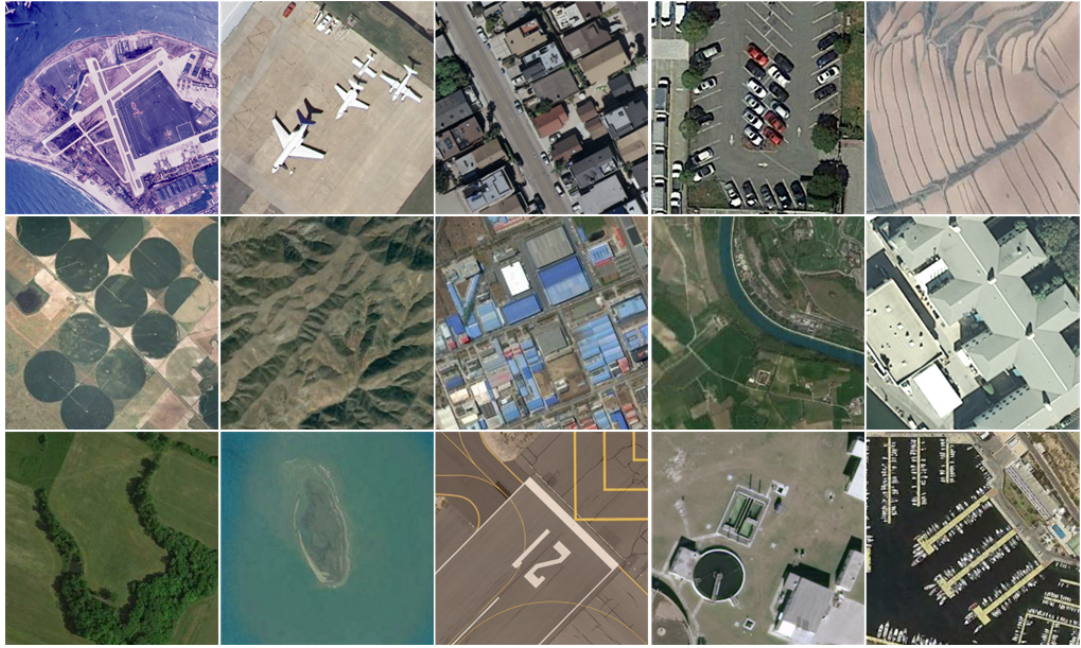
Figure 3. Experimental test images, including the following images: aerial, airplane, residential, parking-lot, terrace, farmland, mountain, industrial-area, river, building, meadow, island, runaway, storage-tank,